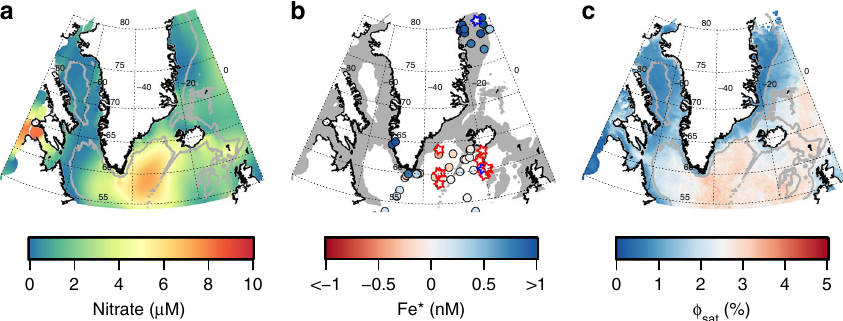
Fig. 1 Indicators of NO 3 or Fe limitation. a Mean World Ocean Atlas (WOA) surface NO 3 concentrations for summer (June, July and August). Gray lines mark the 1 km isobath. b Fe* (circles) derived from summertime dissolved Fe and NO 3 data, and observations of Fe limitation (red stars) and NO 3 limitation (blue stars) in shipboard bioassays. Gray shading represents bathymetry <1 km depth. c Satellite-derived quantum yield of fl uorescence for June, July and August climatological average (2002 – 2016). Higher quantum yields (red colors) potentially indicate higher